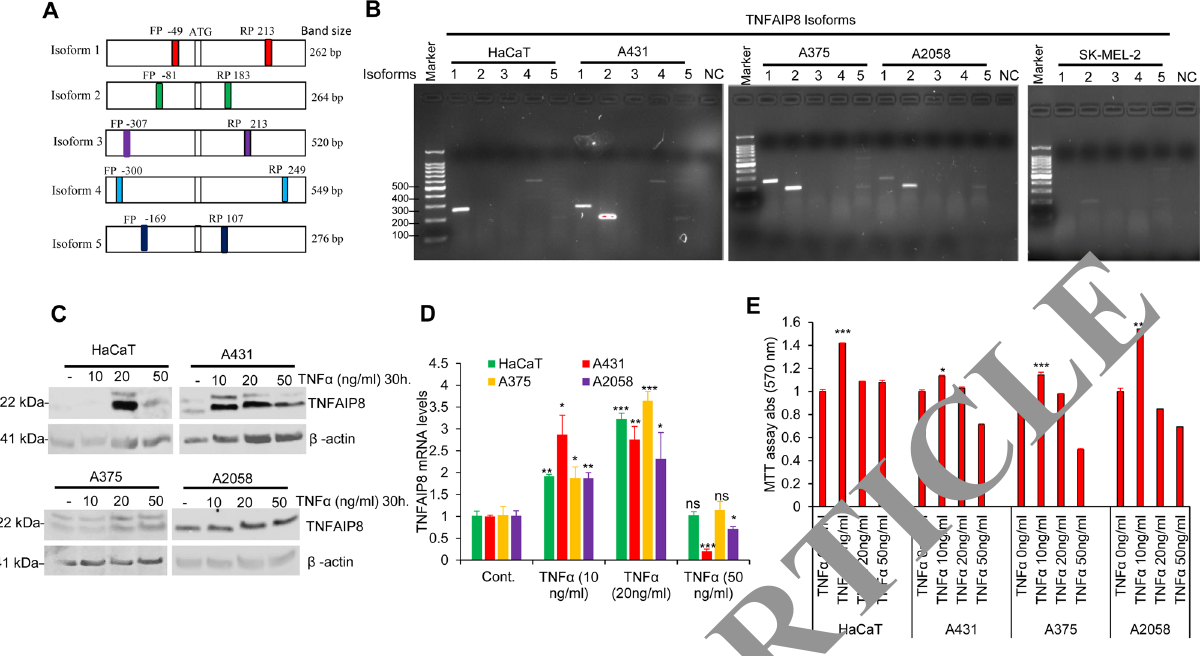
Figure 2. TNFα-induced TNFAIP8 expression in skin cancer cells ( A ) Schematic represents TNFAIP8 isoform-specific forward and reverse primer design. ( B ) The expression of different variants/isoforms of TNFAIP8 in normal HaCaT and skin cancer cells was analyzed by RT-PCR. NC–negative control (no cDNA). ( C ) HaCaT, A431, A375, and A2058 cells were treated with vehicle or TNFα (10–50 ng/ml) for 30 h, and cell lysates were immunoblotted with TNFAIP8 or β-actin antibodies. Immunoreactive bands were visualized using ECL chemiluminescence detection reagents and the blots were scanned using an Odyssey CLx imager. The immunoblot scans were converted into grayscale and presented. ( D ) Similarly, normal and skin cancer cells were treated with vehicle or TNFα (10-50 ng/ml) for 30 h, and TNFAIP8 mRNA expression was analyzed by RT/ qPCR as described in the “Materials and methods” section. * P < 0.05, ** P < 0.01, *** P < 0.001 relative to control/ vehicle-treated cells. ( E ) HaCaT, A431, A375 and, A2058 cells were treated with vehicle or TNFα (10–50 ng/ ml) for 48 h and, relative cell survival was analyzed by MTT assay as described in the “Materials and methods” section. Results are representative of three independent experiments. * P < 0.05, *** P < 0.001 relative to control/ vehicle-treated